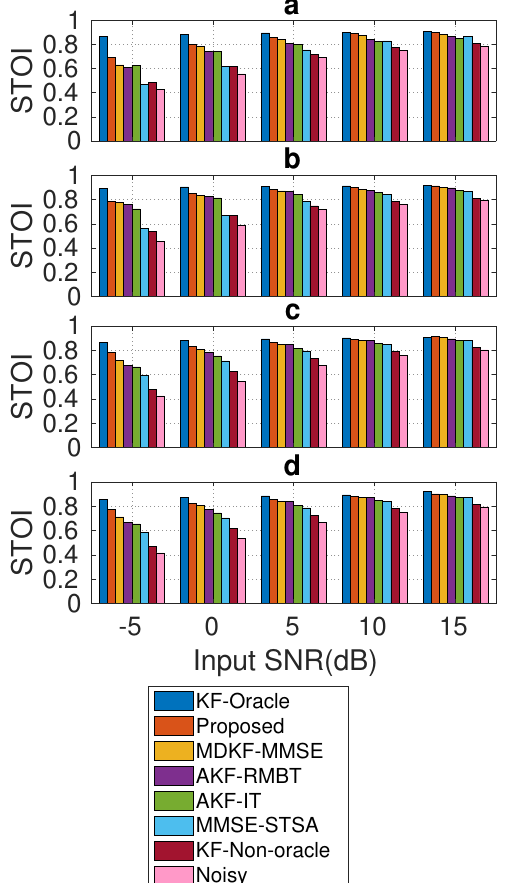
Figure 10. Average STOI score comparison between the proposed and benchmark SEAs on NOIZEUS corpus corrupted with: ( a ) babble , ( b ) street , ( c ) factory2 , and ( d ) f16 noises for a wide range of SNR levels (from − 5 dB to 15